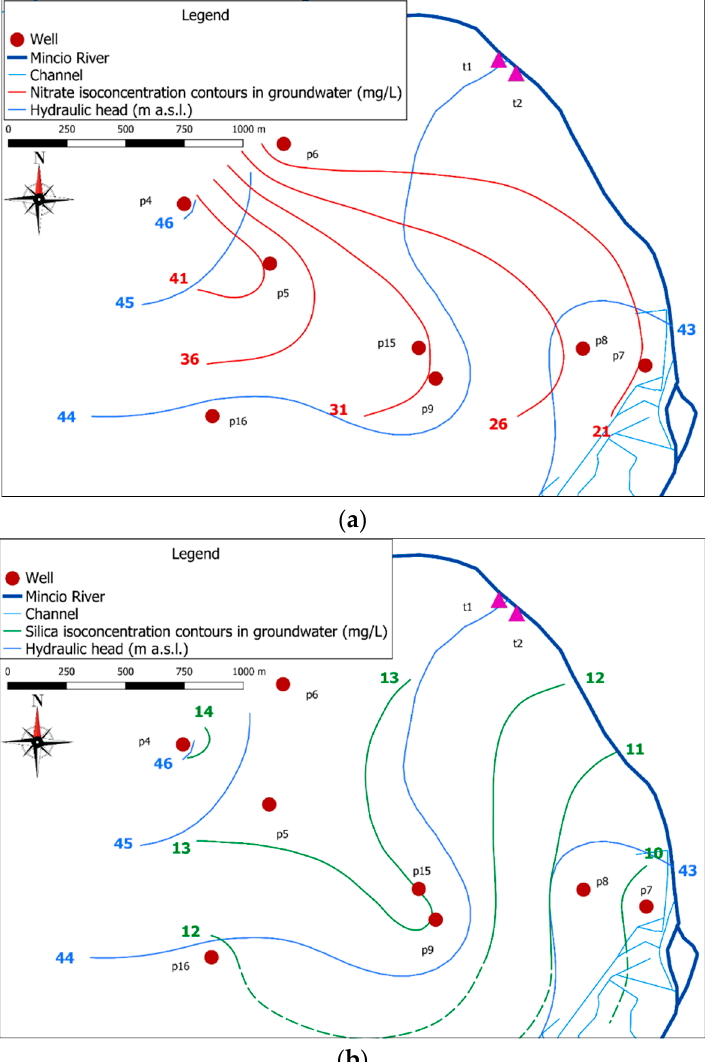
Figure 10. ( a ) Distribution of nitrate concentrations in the northern part of the study area (November 2019); ( b ) distribution of silica concentrations in the northern part of the study area (November 2019).